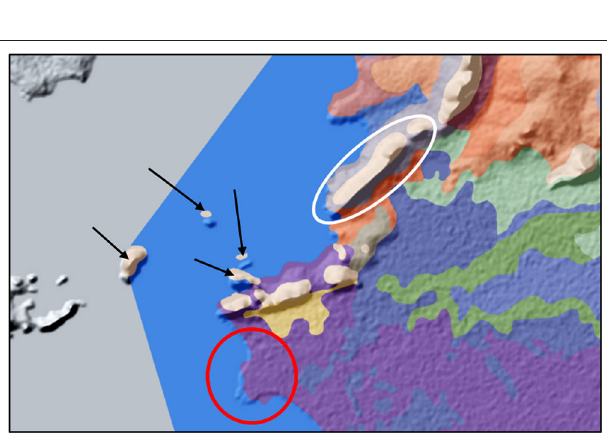
FIGURE 6 | Using a hillshade to identify and correct inaccurately drawn soil map units. Black arrows show inaccurately drawn soil map units occurring on islands. Soil map unit within the red circle shows an incorrect boundary between that soil map unit and the water body. The soil map unit within the white boundary shows a map unit that is meant to represent soils of the